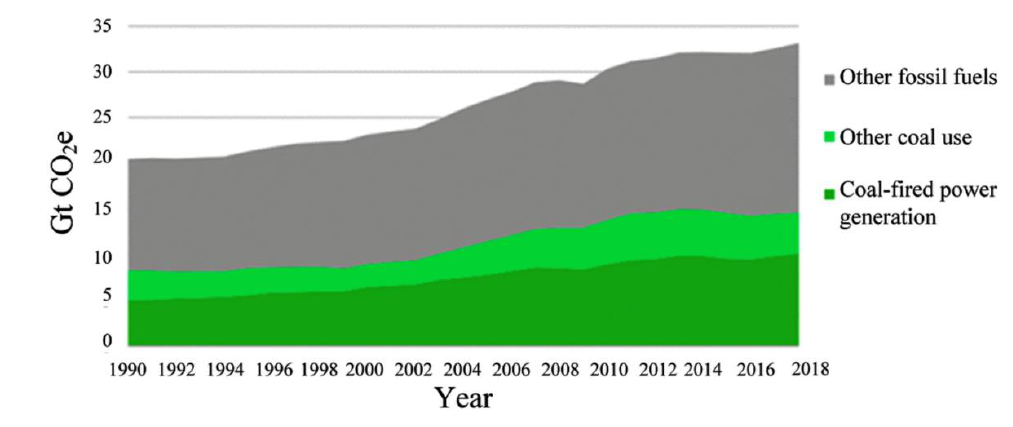
Figure 82. Global energy related carbon dioxide emissions by source, 1990–2018; the CO2 emissions are dreadfully increasing and call for immediate measures.